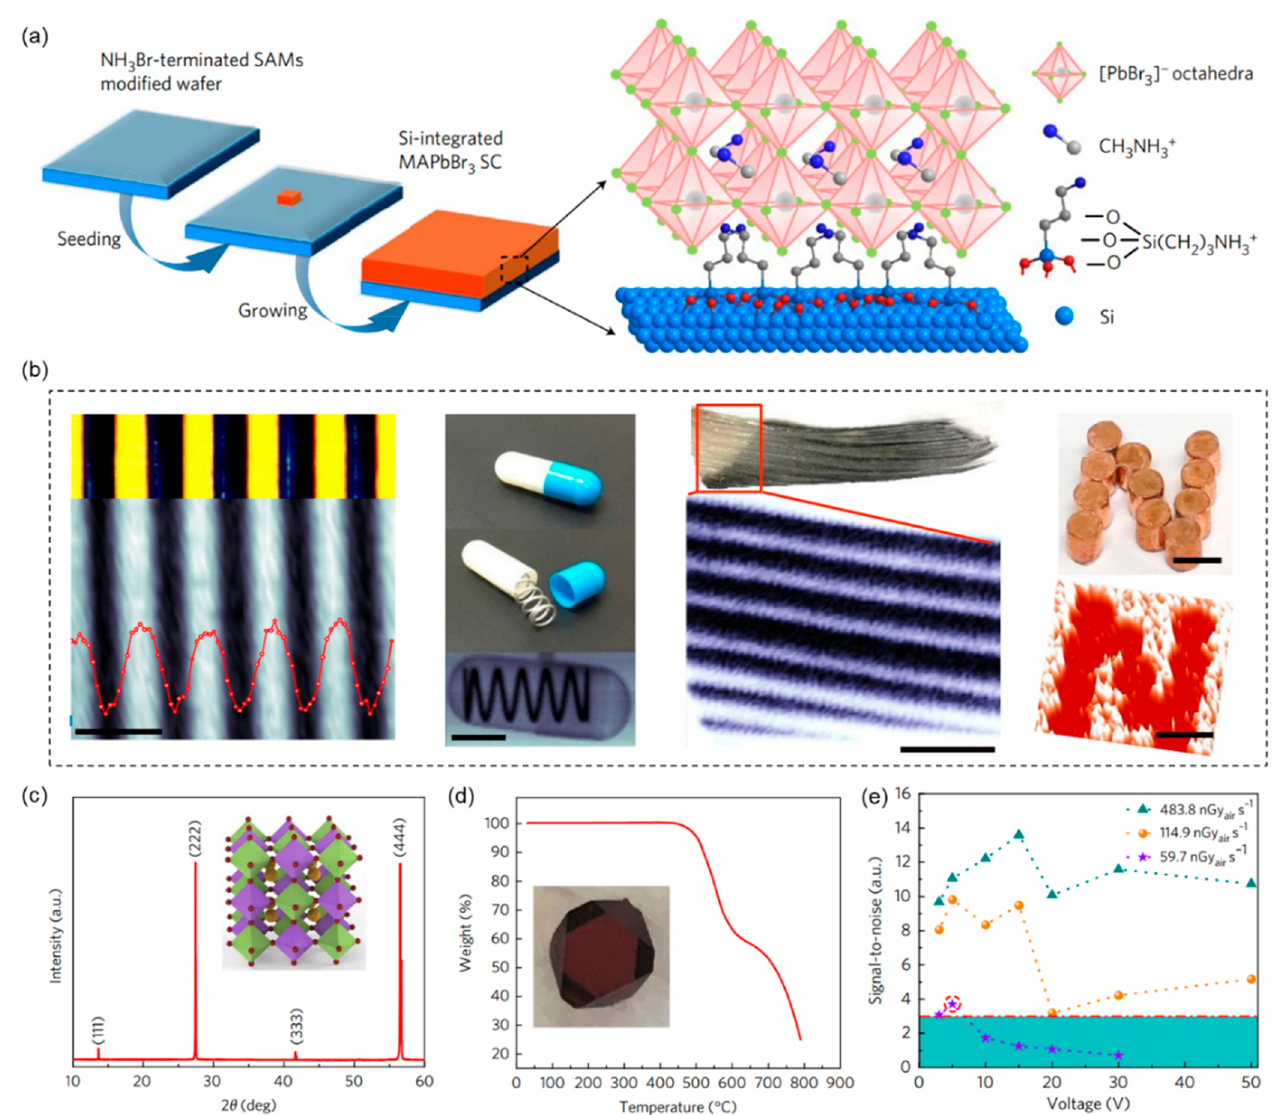
Figure 4. 3D organic–inorganic hybrid perovskites-based X-ray detectors. ( a ) Preparation diagram of Si-integrated MAPbBr 3 single crystal. Reprinted with permission from Ref. [53]. 2017, Springer Nature. ( b ) This device was used for the X-ray imaging in stacked glass coverslips; a stainless-steel plate with etched-through lines, a wrapped metal spring, a section of the tail fin, and an “N” copper sign gave a dose rate of 247 nGy air s − 1 . Reprinted with permission from Ref. [53]. 2017, Springer Nature. ( c ) X-ray diffraction of Cs 2 AgBiBr 6 single crystal. Illustration: Crystal structure. The small wine ball represents Br − , the large khaki ball represents Cs + , and the light green and purple octahedra represent the AgBr 6 and BiBr 6 octahedra, respectively. Reprinted with permission from Ref. [54]. 2017, Springer Nature. ( d ) Thermogravimetric analysis of Cs 2 AgBiBr 6 . Included is a photograph of a solution-processed Cs 2 AgBiBr 6 single crystal. Reprinted with permission from Ref. [54]. 2017, Springer Nature. ( e ) The signal-to-noise ratio of the device is calculated from the standard deviation of the X-ray photocurrent. The red dashed line represents a signal-to-noise ratio of 3, and thus the detection limit is 59.7 nGy air s − 1 at 5 V bias; it is represented by purple stars surrounded by red dotted circles. Reprinted with permission from Ref.[54]. 2017, Springer Nature.